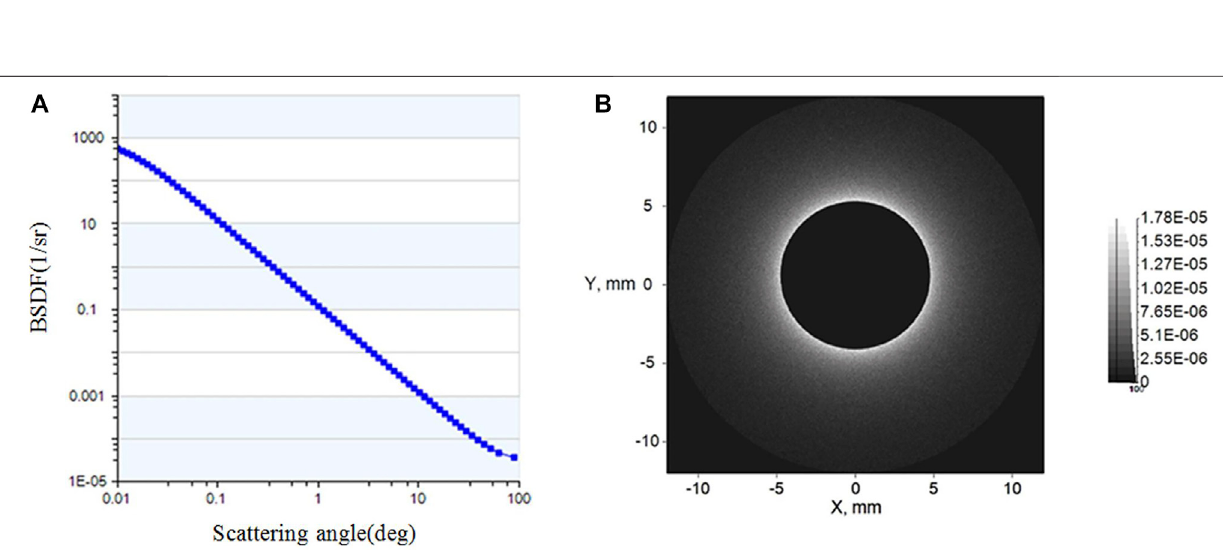
Frontiers in Physics |